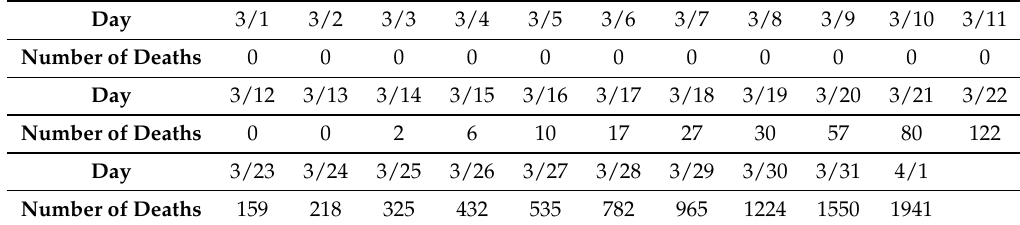
Table 2. Total number of deaths reported in NY state from 1 March to 1 April. See